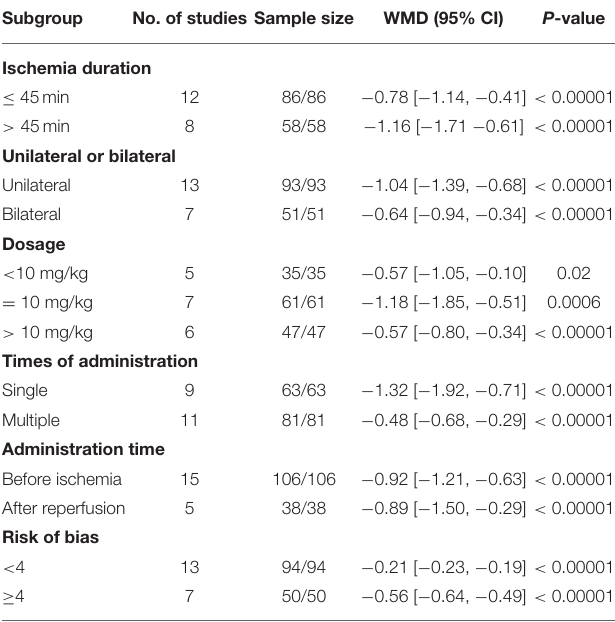
TABLE 4 | Subgroup analysis of pooled estimates of